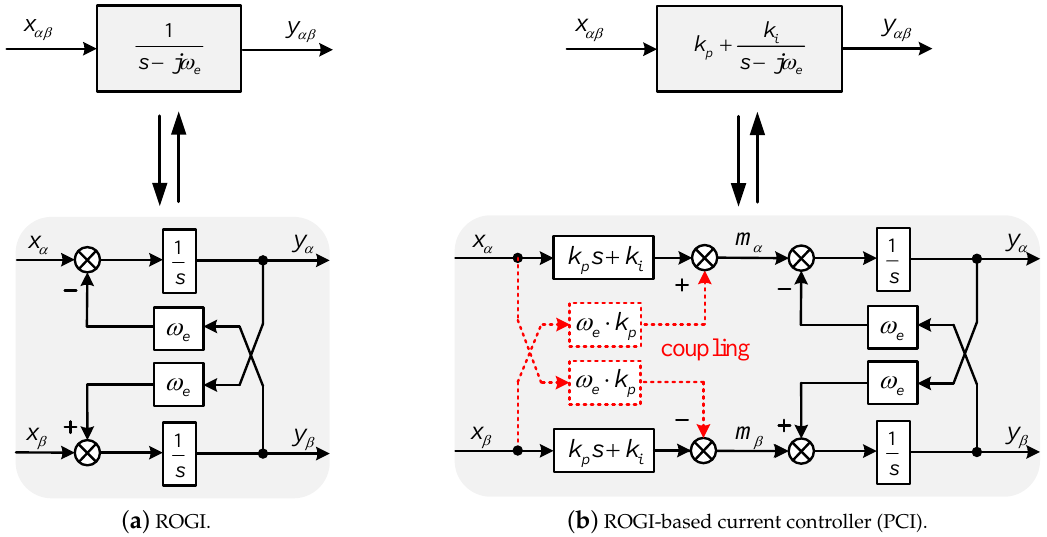
Figure 2. Implementation principle of ROGI and ROGI-based current